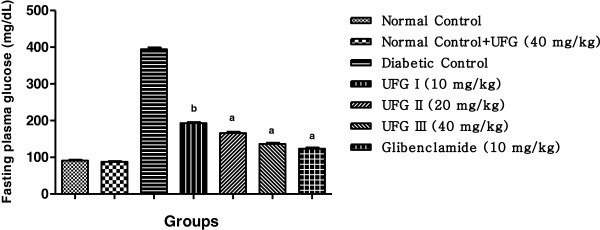
Effect of umbelliferone β-D-galactopyranoside on fasting plasma glucose at different concentrations on STZ induced diabetic rats, compared to diabetic control group rats; values are mean ± SEM; n = 6;
c
P < 0.05;
b
P < 0.01;
a
P < 0.001; P > 0.05 is considered as non-significant (ns).